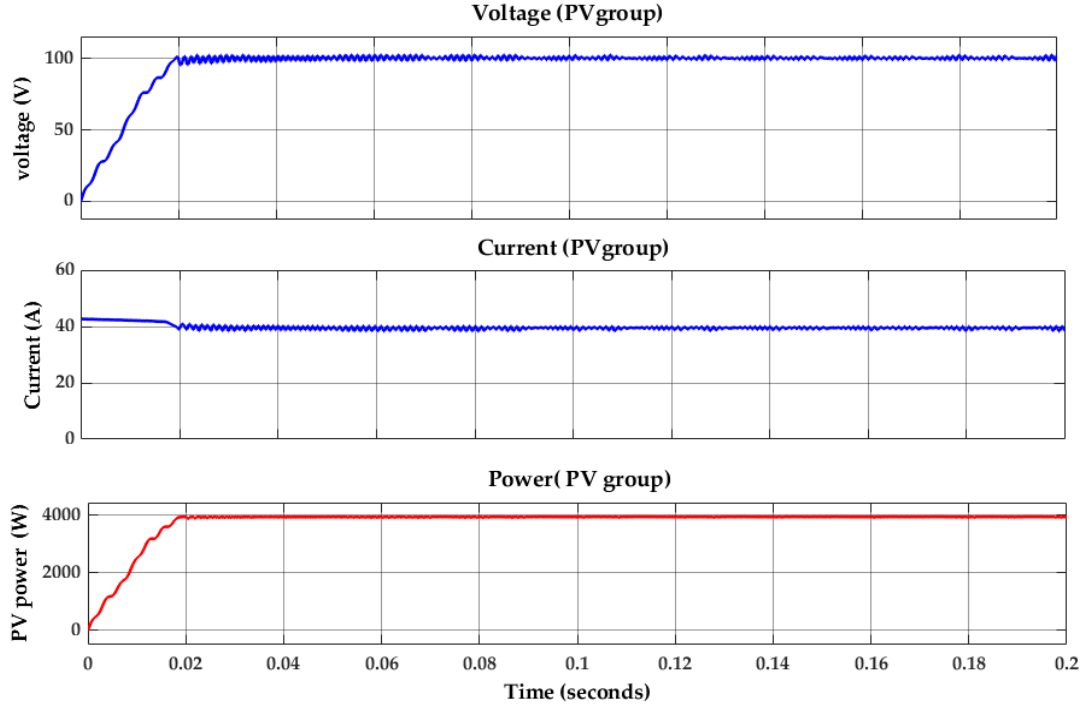
Figure 24. Output voltage, current, and power of each PV group.